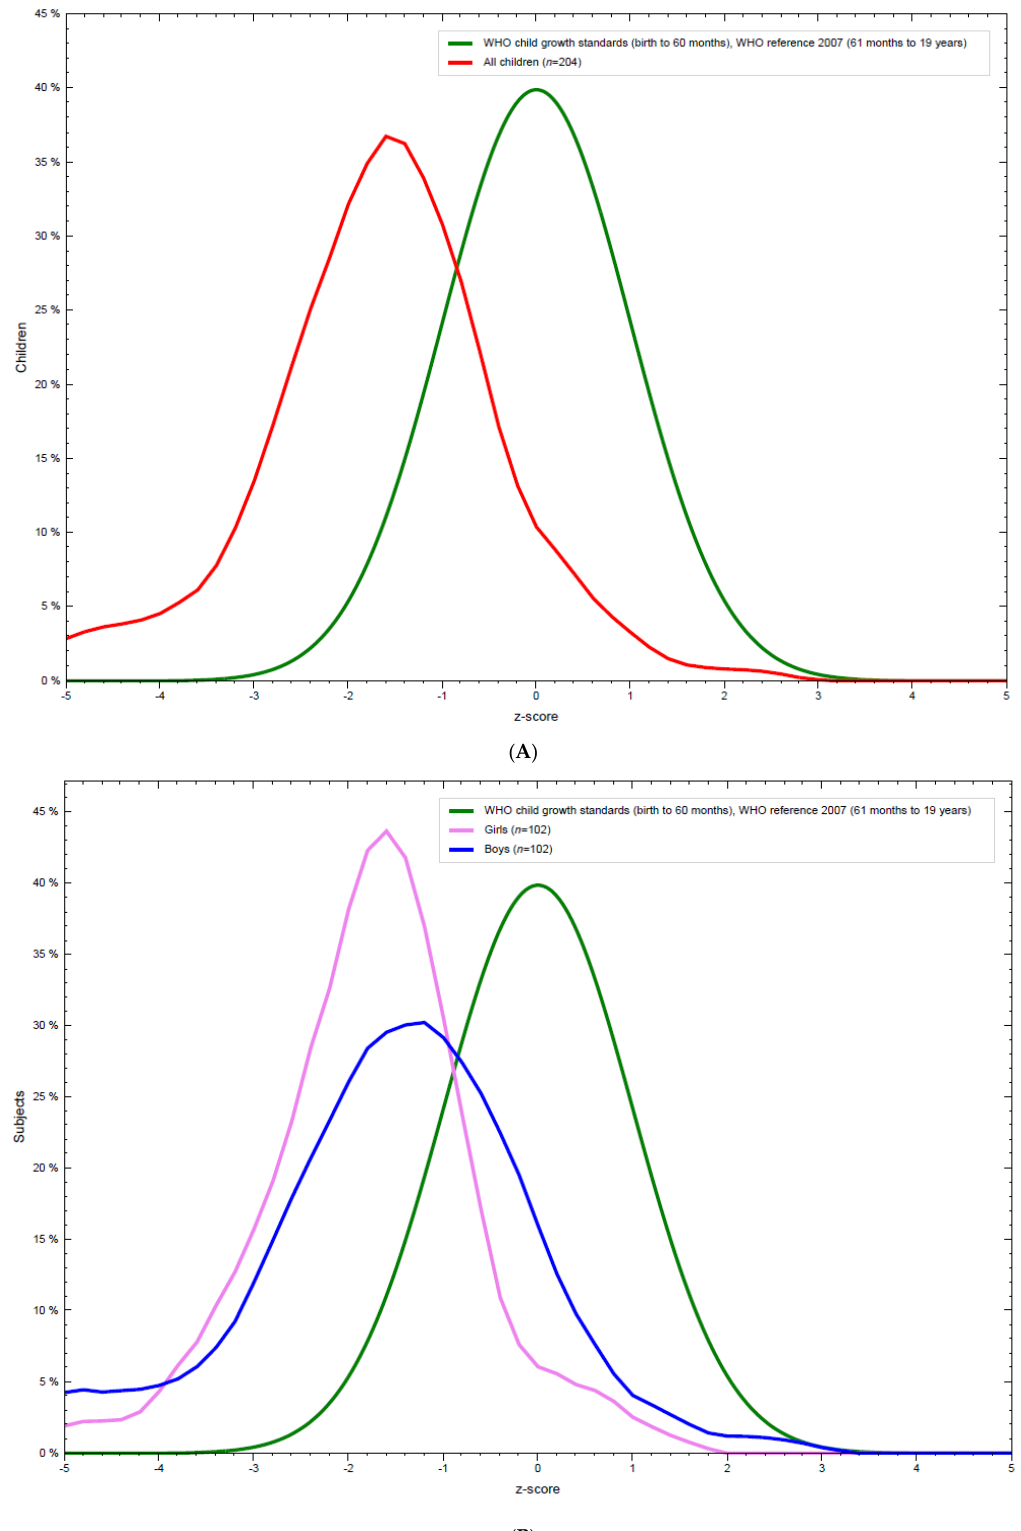
Figure 2. ( A ) Distribution of height-for-age of the adolescents compared to WHO standard. ( B ) Distribution of height-for-age stratified by sex of the adolescents.